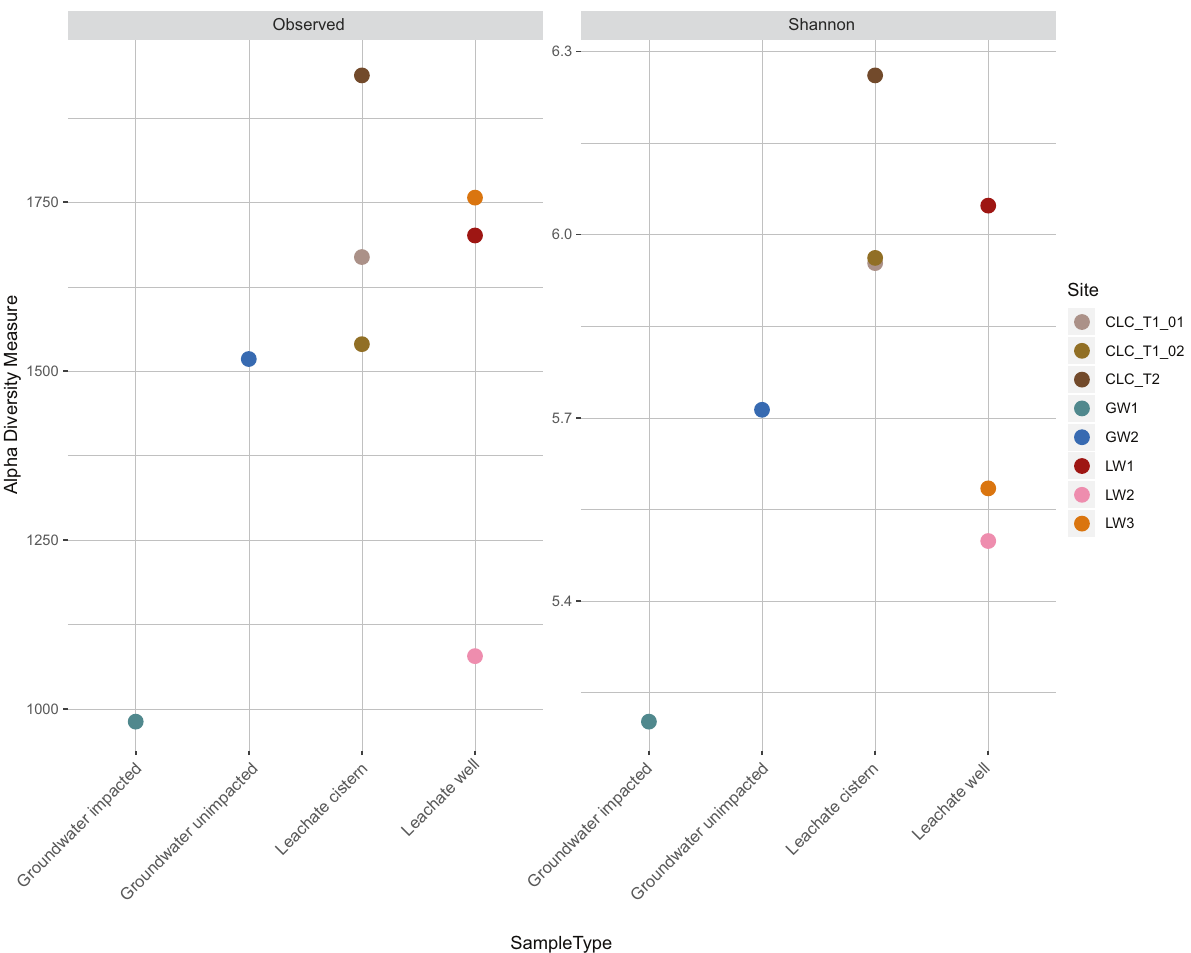
Fig. 3 Observed diversity and Shannon index for the eight land fi ll-associated samples. Observed 16 S rRNA gene amplicon ASVs fall between 986-1998 total ASVs for each sample, indicating similar levels of microbial community heterogeneity across sites. All sites show a high level of diversity, with Shannon indices greater than 5. Samples are grouped by sample type on the x